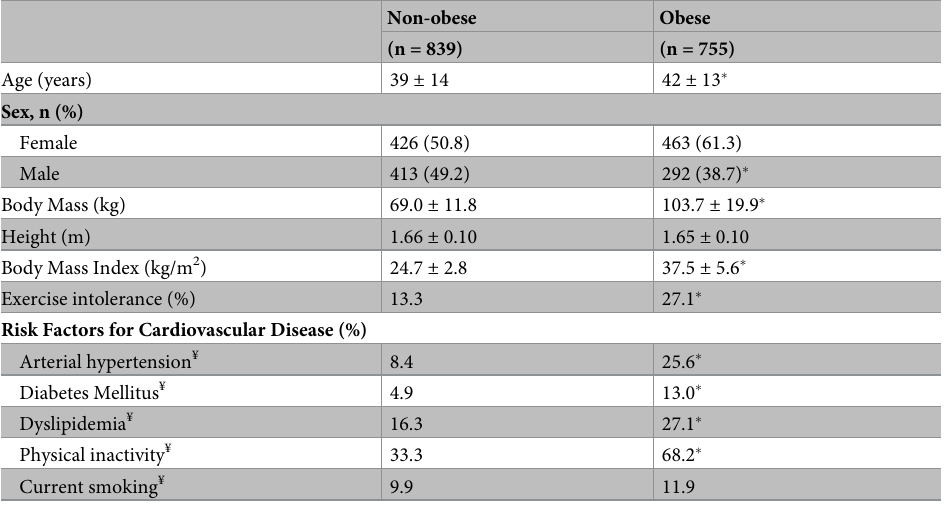
Table 1. General characteristics of the sample stratified as non-obese and obese (n = 1,594).